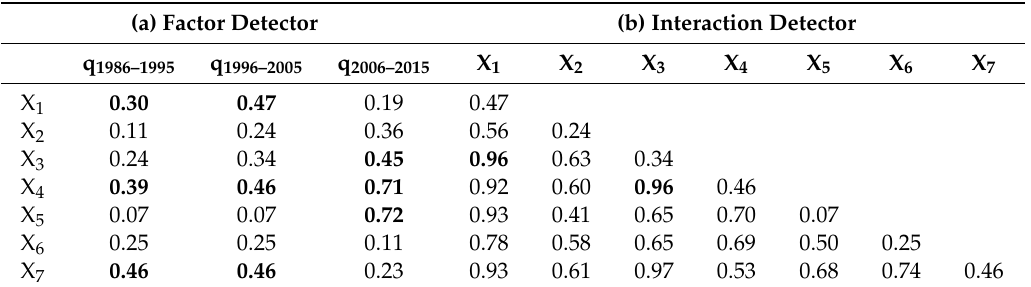
Table 5. The q values of ( a ) factor detector, and ( b ) interaction detector analysis of cities in the GBA during